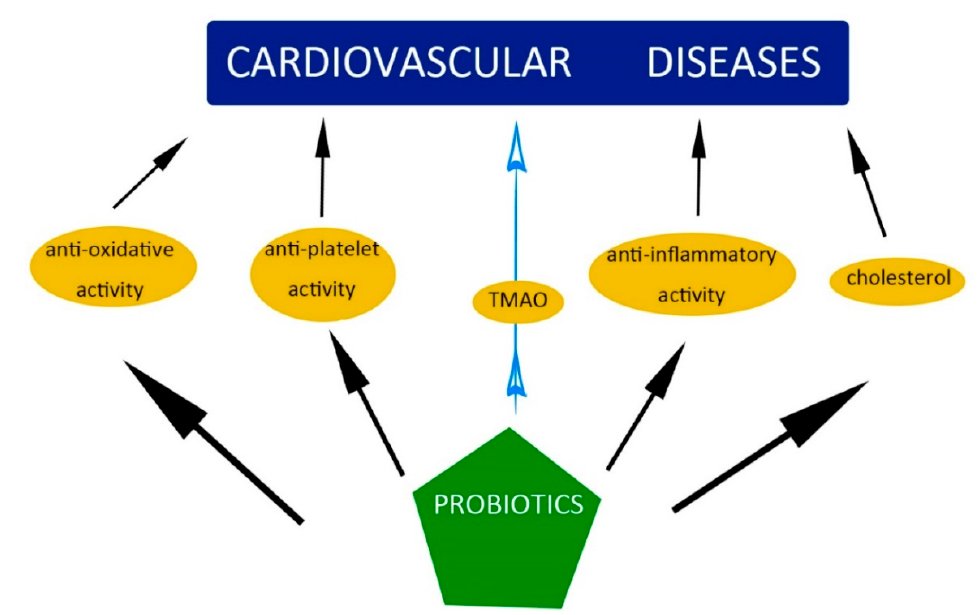
Figure 3. The impact of probiotics on cardiovascular disease (CVD).